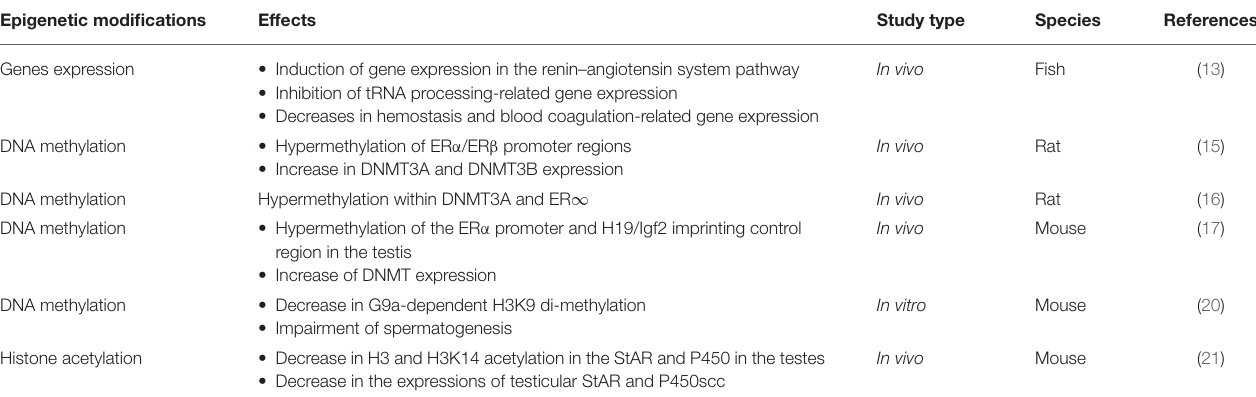
TABLE 2 | Characteristics of the studies which analyzed hormonal axis disturbances.